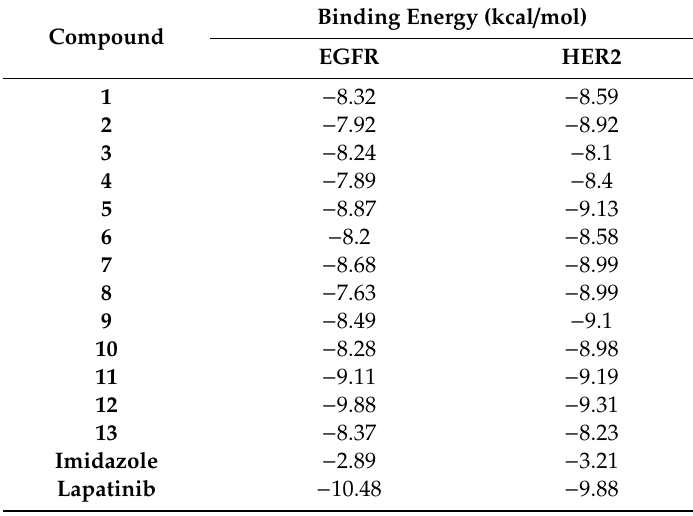
Table 3. Docking scores of the synthesized triphenyl imidazoles with their